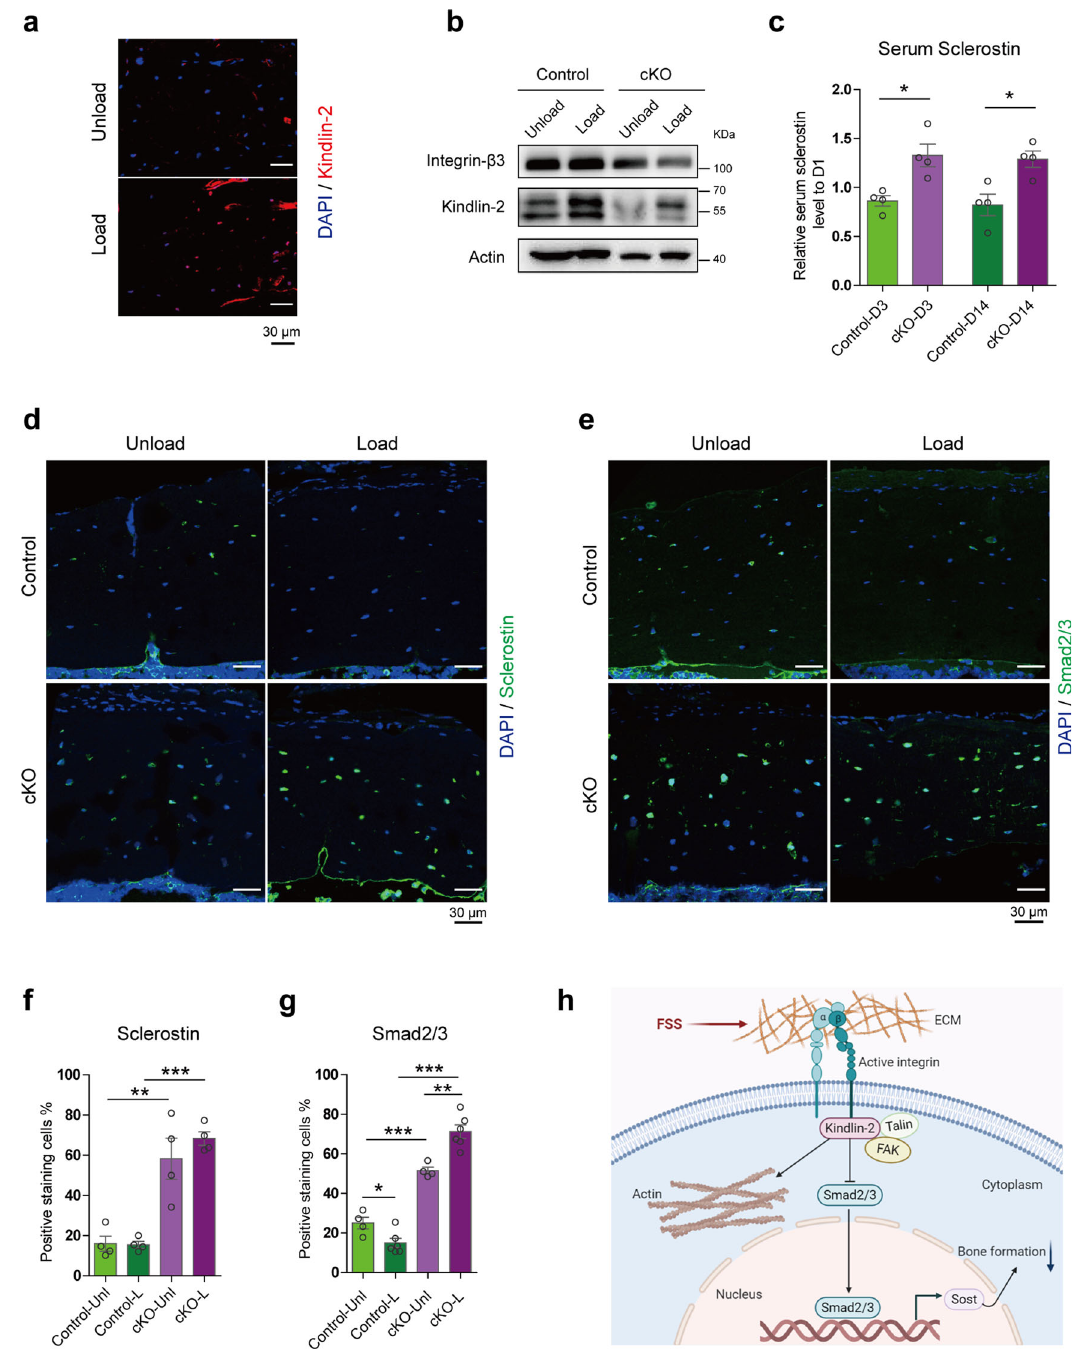
Fig. 6 Kindlin-2 deletion in osteocytes enhances Sclerostin and Smad2/3 expression upon mechanical loading in mice. a Immuno fl uorescence staining of Kindlin-2 in the midshaft of tibial cross sections from unloaded and loaded limbs of 4-month-old control male mice. b Protein levels of integrin- β 3, Kindlin-2, and β -Actin detected with western blotting in 4-month-old control and cKO male mice in unloaded and loaded tibia samples. c Serum Sclerostin levels from ELISA detection at loading Day 3 (D3) and Day 14 (D14) relative to Day 1 (D1, before loading) in control and cKO mice. N = 4 for each group. d IF staining of Sclerostin (green) merged with DAPI (blue) in tibia sections from control and cKO mice. e IF staining of Smad2/3 (green) merged with DAPI (blue) in tibia sections from control and cKO mice. Quantitative analysis for Sclerostin-positive ( f ) and Smad2/3-positive ( g ) cells in tibia sections from control and cKO mice. N = 4 – 6 for each group. h Working model. * P < 0.05, ** P < 0.01, *** P < 0.001, versus controls, Student ’ s t test. Results are expressed as mean ± standard deviation